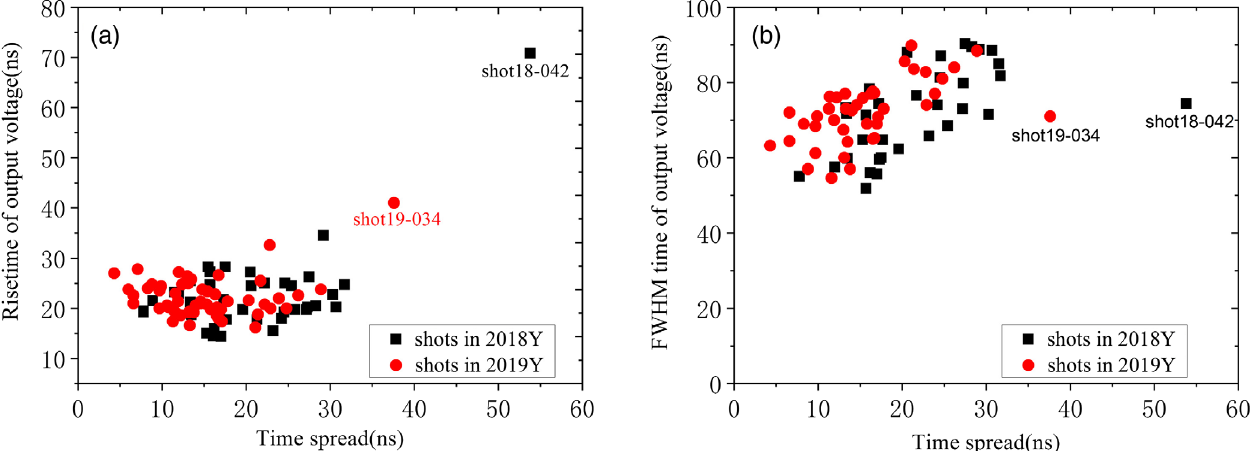
FIG. 16. Effects of the first-to-last time spread ( t ) on the rise time and FWHM time of output voltages in a statistics of almost 100 spread shots. (a) rise time, and (b) FWHM time. The black dots represent the shots conducted in 2018, while the red dots represent the shots in 2019 after a maintenance on the four electrically triggered gas switches to improve the drive